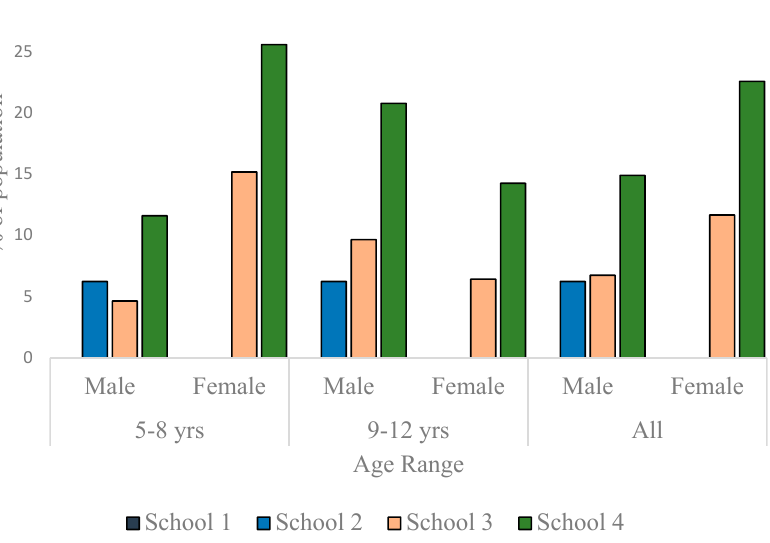
Figure 6. Prevalence of obesity among children in the studied schools.